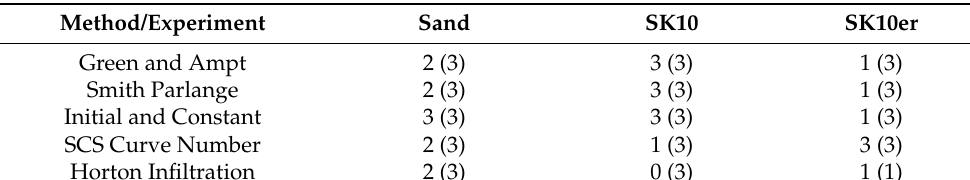
Table 6. Ranking-based performance metrics of different tested rainfall loss methods according to the methodology shown in Section 2.3. Values outside and inside brackets indicate performance with initial model parameters and after manual calibration, respectively.